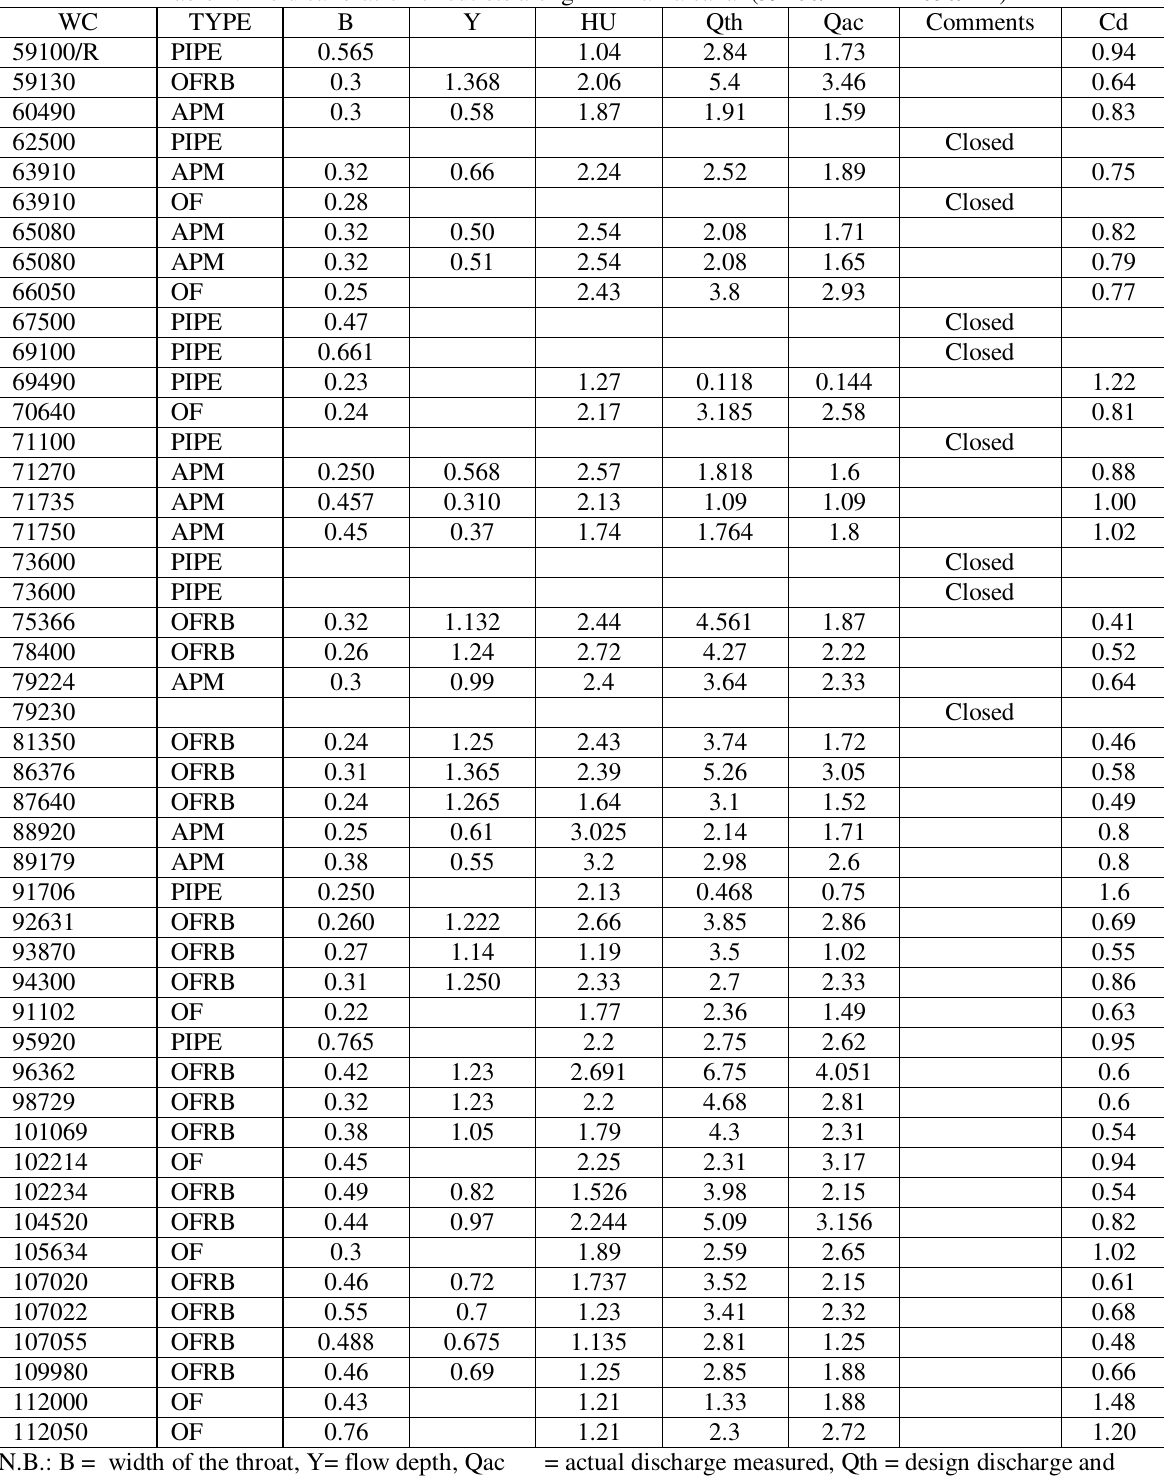
Table 1: Field calibration of outlets along 4-R Hakra canal (59100/RD -